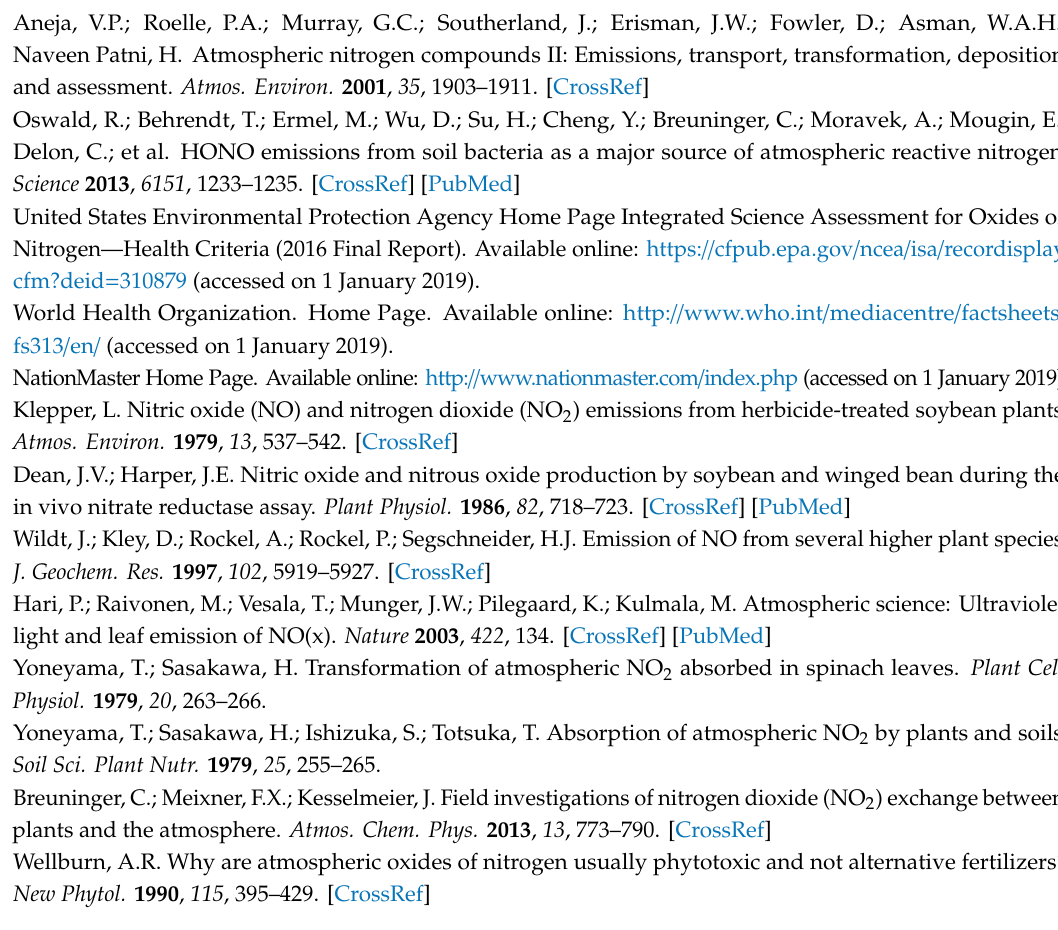
Table S1: Shoot biomass (mg), total leaf area (mm 2 ), and content ( µ g / shoot) of carbon (C), nitrogen (N), phosphorus (P), potassium (K), calcium (Ca), magnesium (Mg), and sulfur (S) in 5-week-old Arabidopsis thaliana C24 plants grown with ( + NO 2 -treated plants) and without (–NO 2 control plants) NO 2 treatment, Table S2: Correlation analysis between leaf area (RLA) and cell size ( RCS), and that between leaf area (RLA) and cell number RCN), Table S3: Identified nitrated proteins and their electrophoretic and mass spectrometric characteristics in chloroplast proteins extracted from Arabidopsis thaliana leaves exposed to NO 2